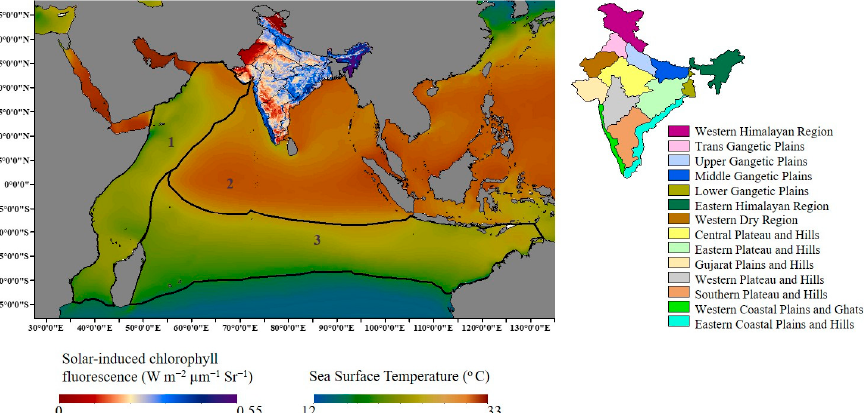
Figure 1. Shows the climatology of SIF (spatial resolution of 0.05 × 0.05-degree grid) across India and SST (spatial resolution of 0.25 × 0.25-degree grid) in the tropical Indian Ocean during the summer monsoon. Indian landmass is divided into 14 agro-climatic zones, and the tropical Indian Ocean is stratified into (1) Western, (2) Northern and (3) Central regions based on the SST pattern. (Software used: ArcMap version 10.3 (Esri Inc. (Redlands, CA, USA, 2014), https://desktop.arcgis.com/en/ arcmap/ (accessed on 10 July